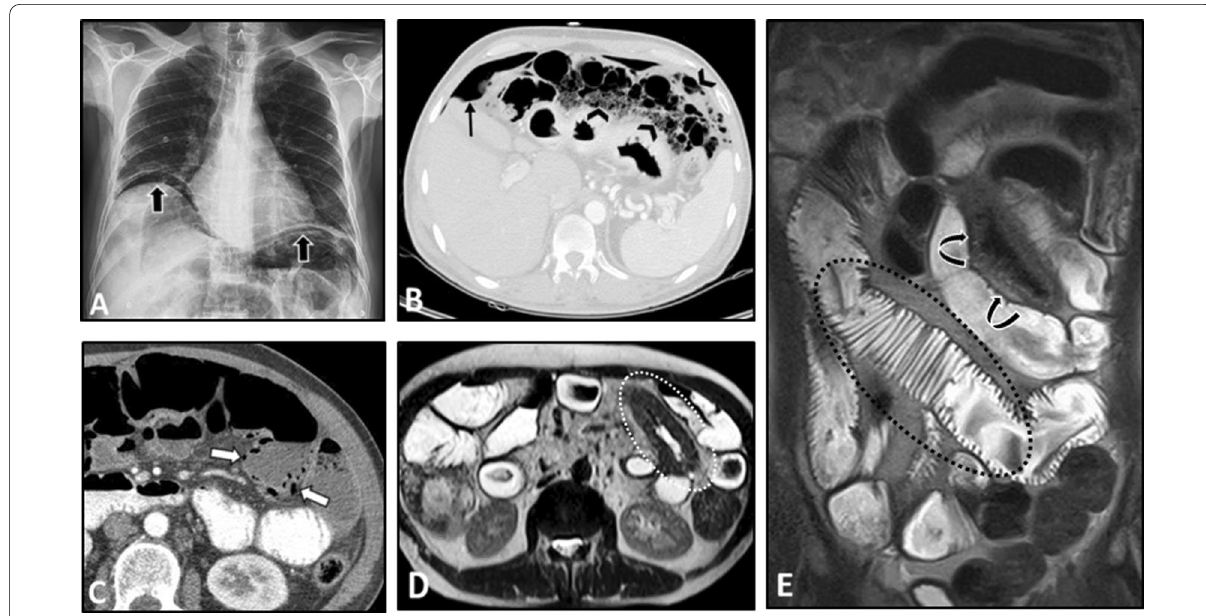
Fig. 18 Intestinal vasculitis and benign intestinal pneumatosis in a 52-year-old male with a history of known Scleroderma presenting with abdominal pain. Physical examination revealed generalized abdominal tenderness without rebound or guarding. Upright CXR ( A ) was done in the ER. Pneumoperitoneum (thick black arrows) was noted at CXR in the absence of signs or symptoms of peritonitis. Due to this discrepancy, abdominal CT scan ( B , C ) was performed and confirmed pneumoperitoneum (thin black arrow) along with extensive intestinal pneumatosis in the transverse colon (black arrowheads) and jejunum (thick white arrows). The patient underwent conservative treatment. He was discharged one week later with improved signs/symptoms. After three weeks, MRE was obtained and displayed no pneumoperitoneum. Axial T2-W image ( D ) demonstrates segmental jejunal mural thickening (white dotted oval) with hypointense appearance. Coronal T2-W image ( E ) shows bowel dilation and the classic hidebound sign (black dotted oval) in the ileum related to known scleroderma. The T2 hypointense segment of thick jejunum is also seen (curved arrows), suggestive of chronic mural thickening perhaps due to fibrosis